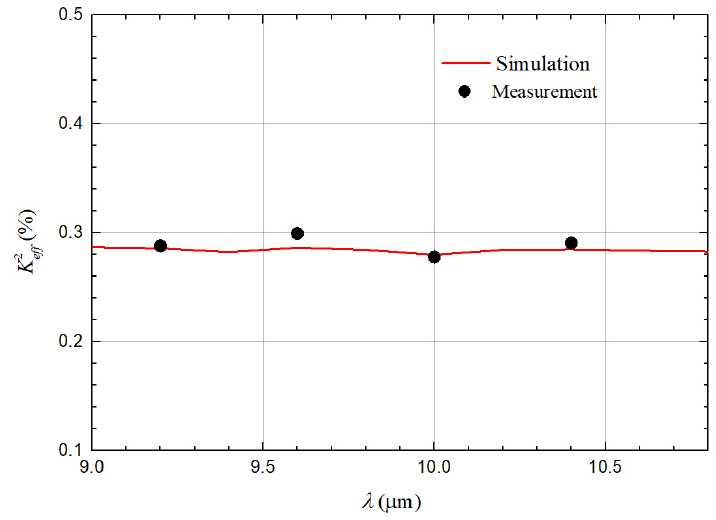
Figure 8. Measured and simulated k 2 of the QSAW resonator with different λ . ef f The TCF s of QSAW resonators with λ of 10.4 µ m, 10 µ m, 9.6 µ m and 9.2 µ m are